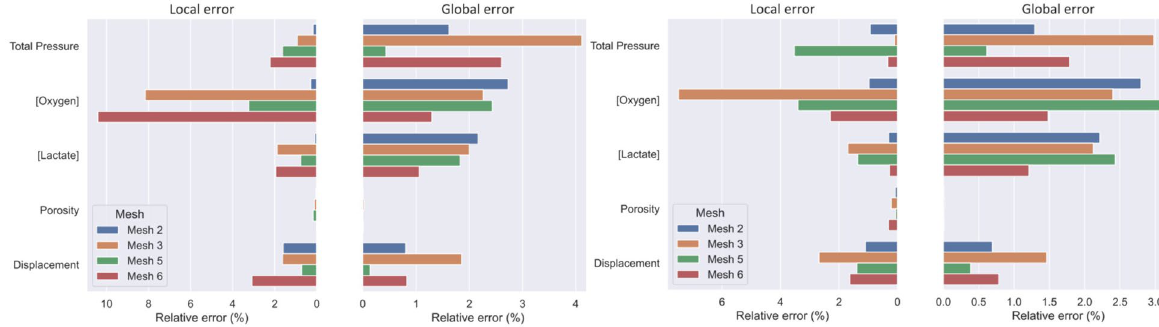
Figure 3. Mesh analysis for LB (left) and AR (right) at the full range of motion. [.] is used to express the concentration.